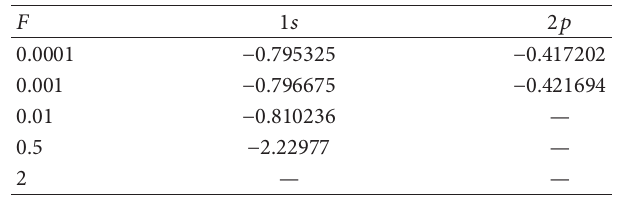
Table 6: When 𝑏 = 0.3 , 𝑐 = 0.5 , and 𝜆 = 300 , 1𝑠 and 2𝑝 energy eigenvalues for different external electric field strengths in atomic units.